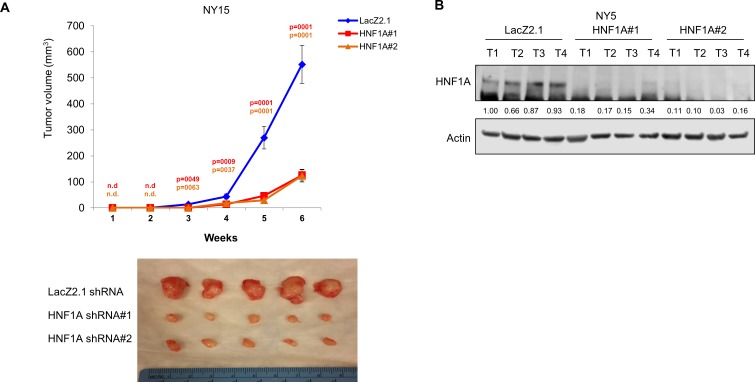
Effects of HNF1A depletion on PDA xenograft biology.(A) 103 control or HNF1A-depleted NY15 cells were implanted subcutaneously in NOD/SCID mice (10 mice per shRNA/bilateral injections) for 6 weeks. Tumors were measured by caliper to determine tumor growth. Statistical difference was determined by one-way ANOVA with Dunnett’s multiple comparisons test. Red and green p values indicate LacZ2.1 vs. HNF1A#1 or #2, respectively. ‘n.d.’ indicates that tumors were not detected. Representative tumors are shown (lower panel). (B) Western blot analysis of HNF1A and Actin from NY5 tumors expressing LacZ2.1 or HNF1A shRNAs (four tumors per group) demonstrating persistent knockdown in vivo. Quantitation of HNF1A is indicated below the blot.